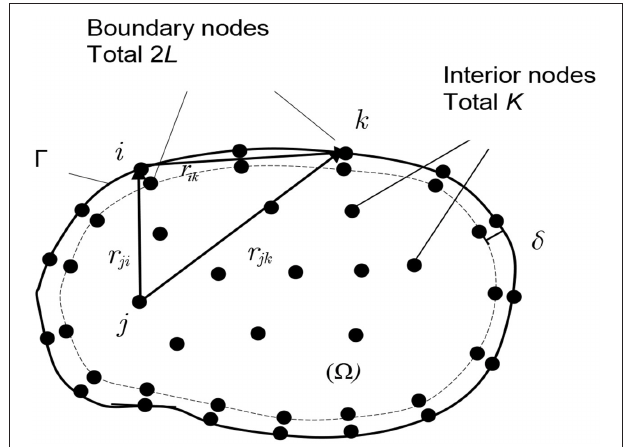
FIGURE 2 | Boundary and domain nodal